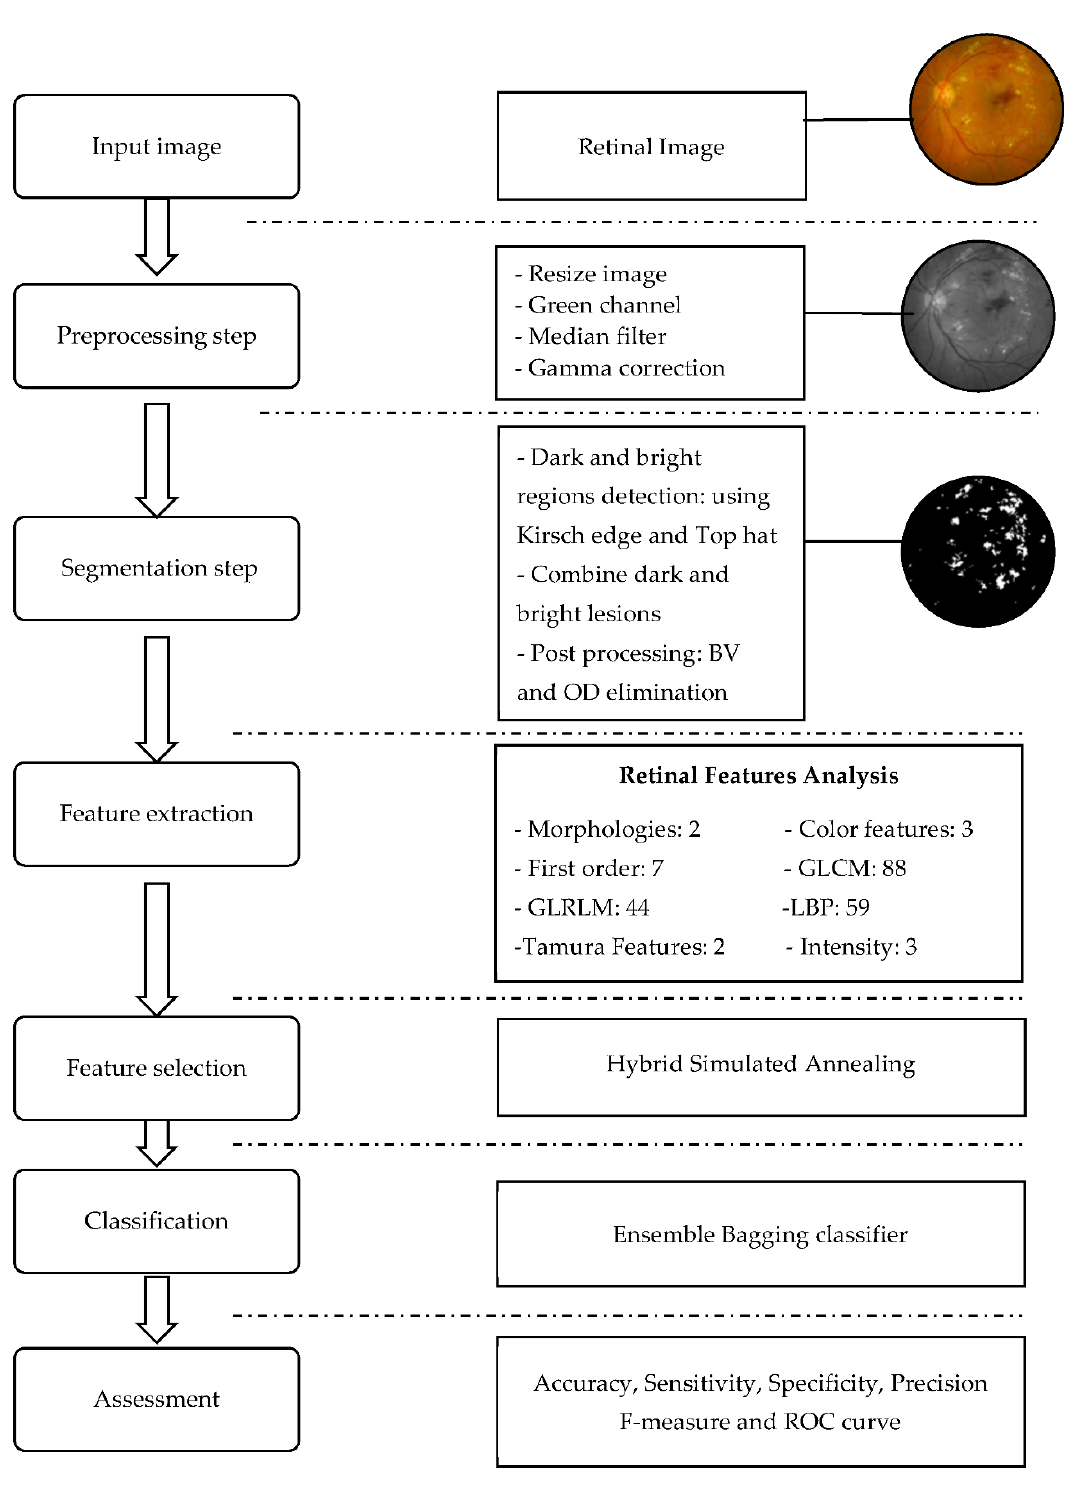
Figure 3. Flowchart of the proposed system.